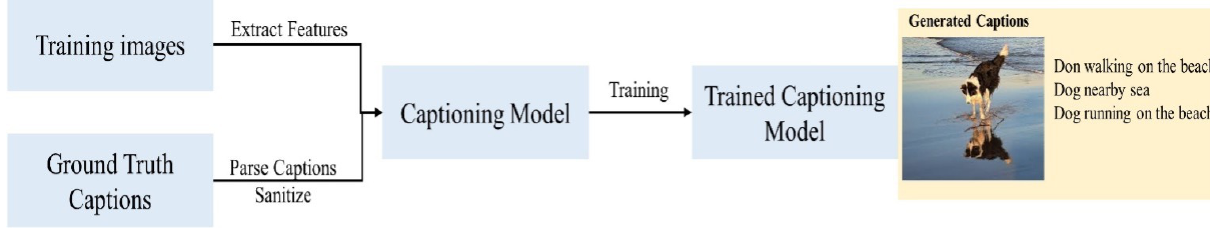
Figure 4. Conceptual diagram of image captioning.